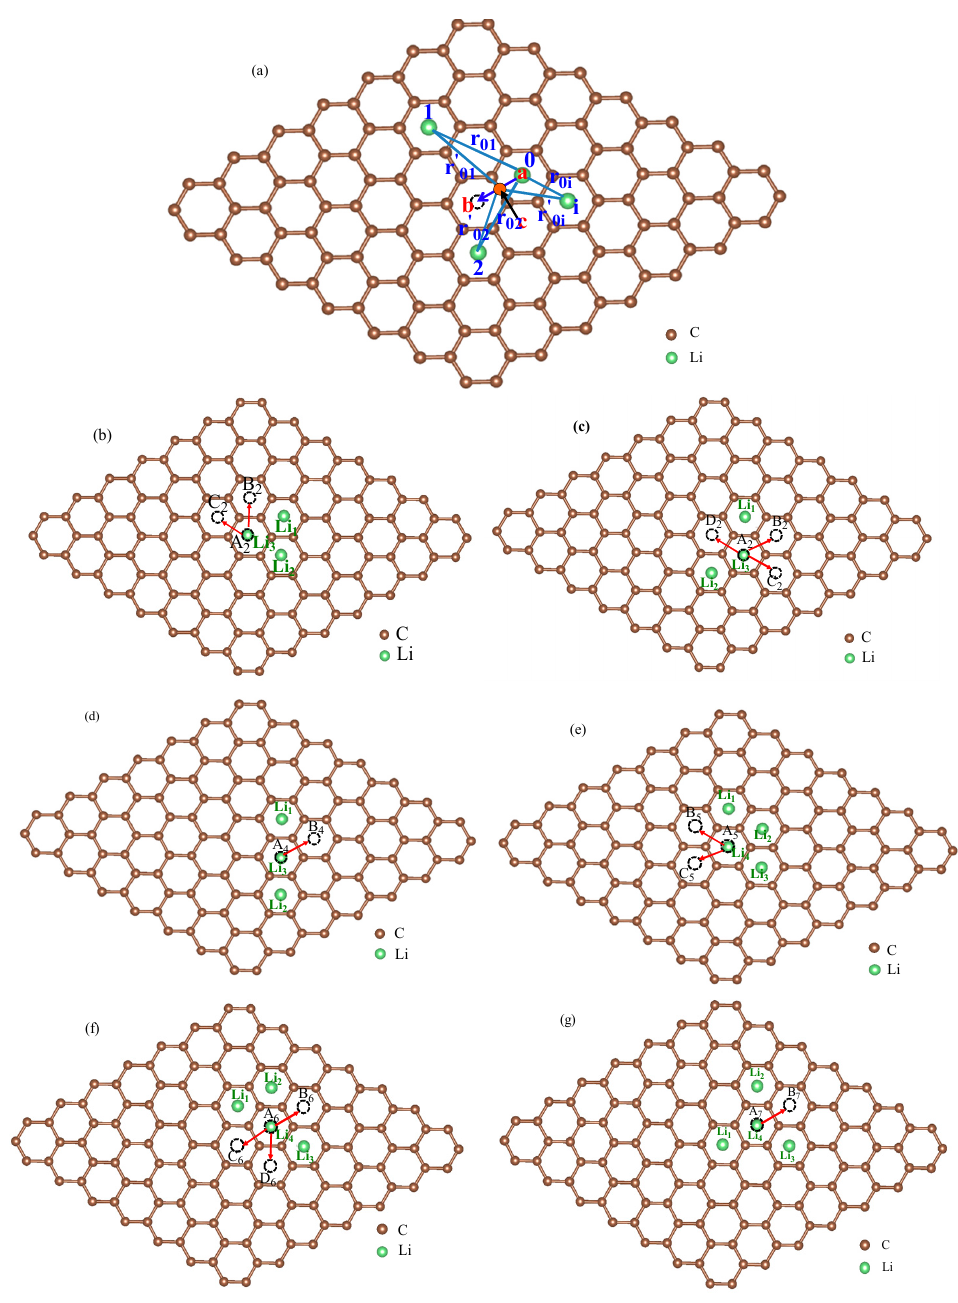
Figure 3. The schematic view of multi-Li + adsorbed graphene system ( a ) and schematic representations for various possible Li + arrangements and Li + ’s possible migration pathways for three-Li + and four-Li + adsorbed systems with one Li + migrating on graphene and the others fixed ( b – g ).